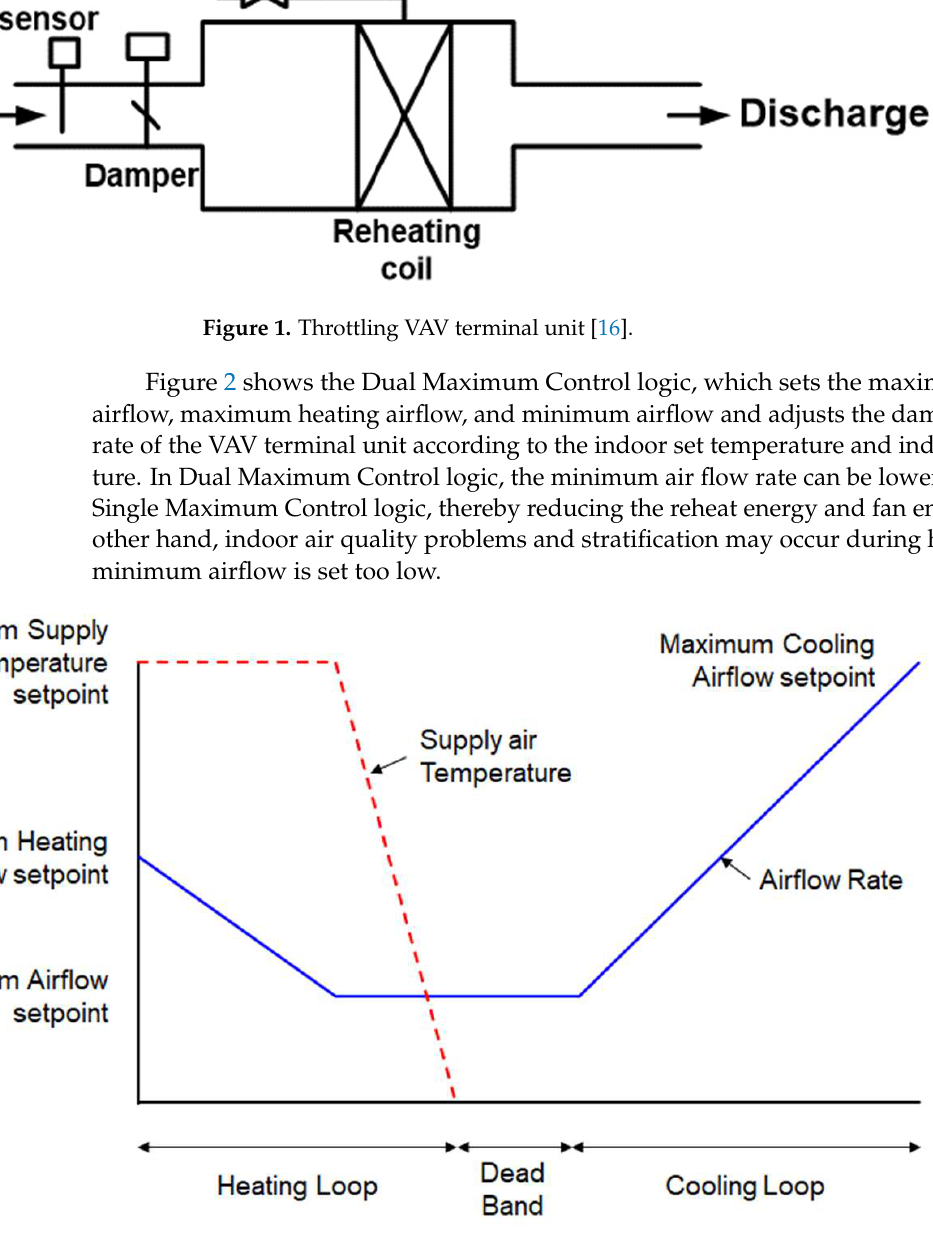
Figure 1. Throttling VAV terminal unit [16].